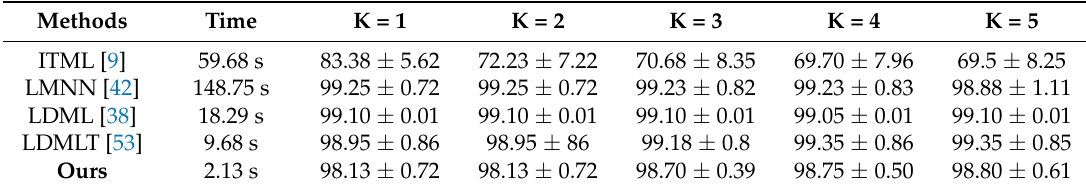
Table 2. The average of recognition rate (%) and training time for different metric learning methods in the AWE database.